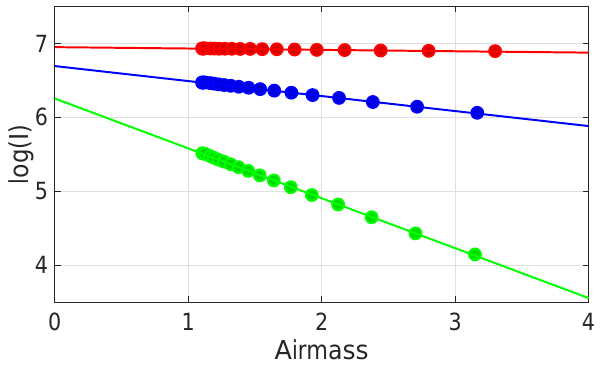
Figure 1. Langley plot using direct solar irradiance measurements of QASUME on the morning of 14 September 2016. The green, blue and red dots represent measurements at 310, 320 and 350nm respectively. The lines represent a linear fit to the data points to retrieve the intercept at air mass